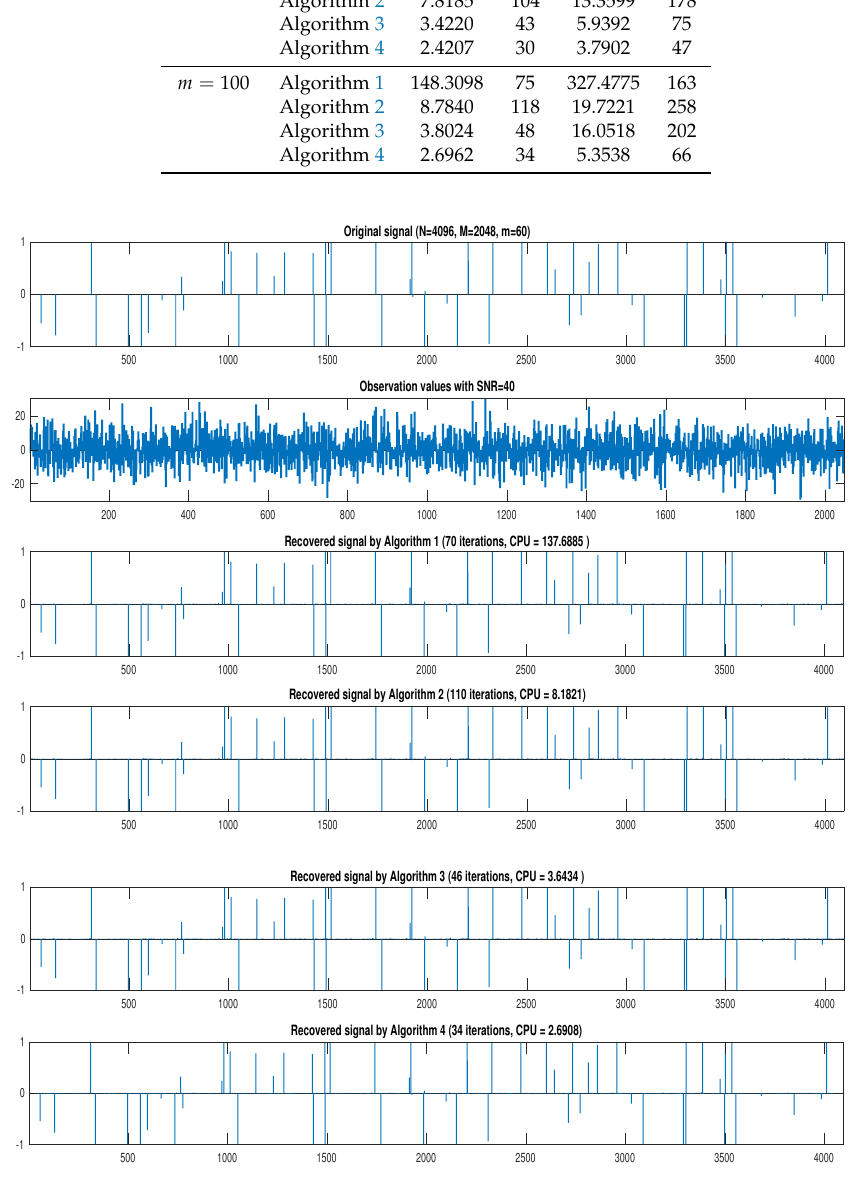
Figure 4. From top to bottom: original signal, observation data and recovered signal by Algorithms 1–4,